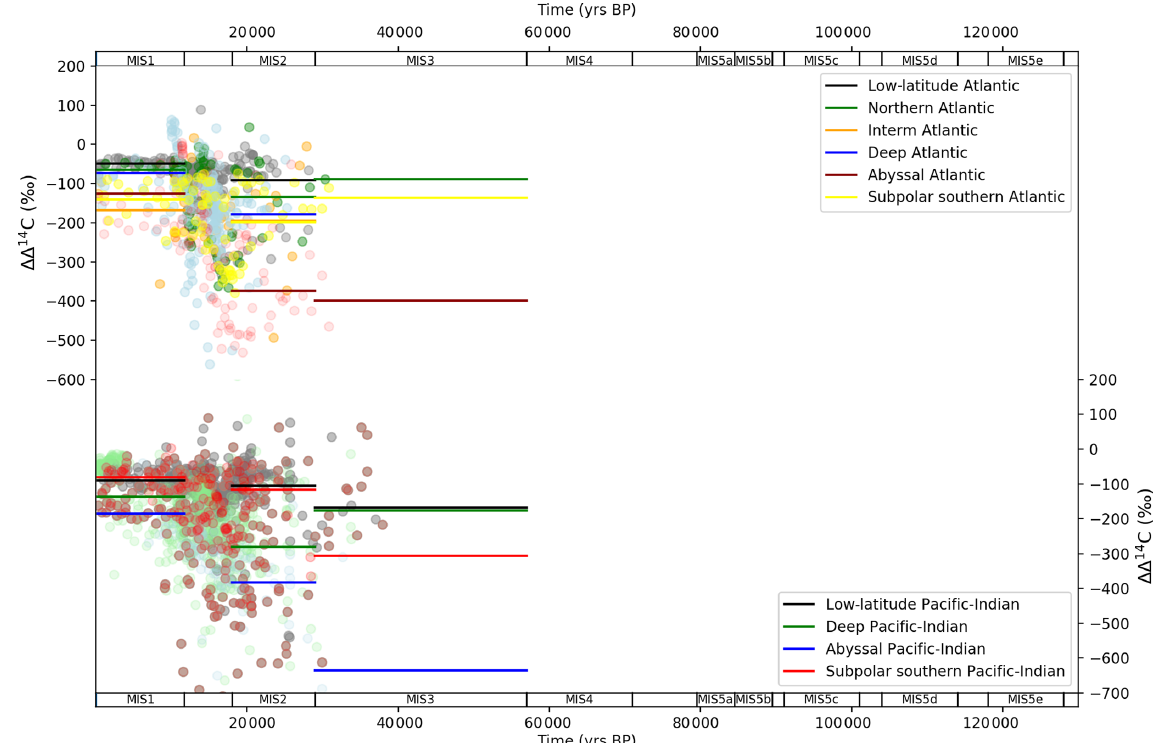
Figure 6. MIS stage ocean data mapped into box model dimensions for (cid:49)(cid:49) 14 C. Data (round circles) are mapped into deep (2500m average depth) and abyssal (3700 (Atlantic)–4000m (Pacific–Indian) average depth) model boxes and averaged across MIS slices (bold lines). Natural observations do not exist beyond ∼ 50ka due to the radioactive decay of 14 C. (cid:49)(cid:49) 14 C is ocean minus atmosphere (cid:49) 14 C. Note that this calculation is not done with the average ocean box and atmosphere values for each MIS; rather (cid:49)(cid:49) 14 C represents the difference between each ocean data point and the contemporary atmospheric (cid:49) 14 C value. Data behind the figure are shown in Table